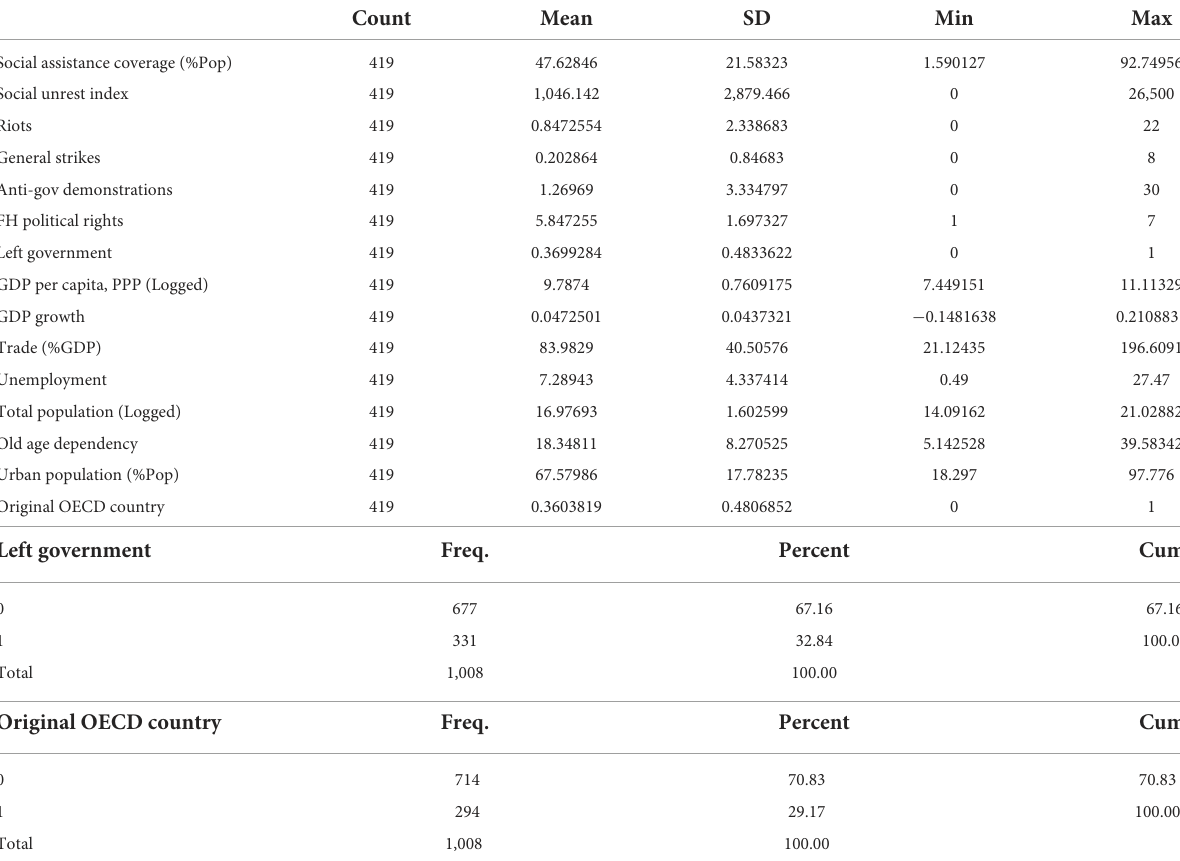
TABLE 1 Summary